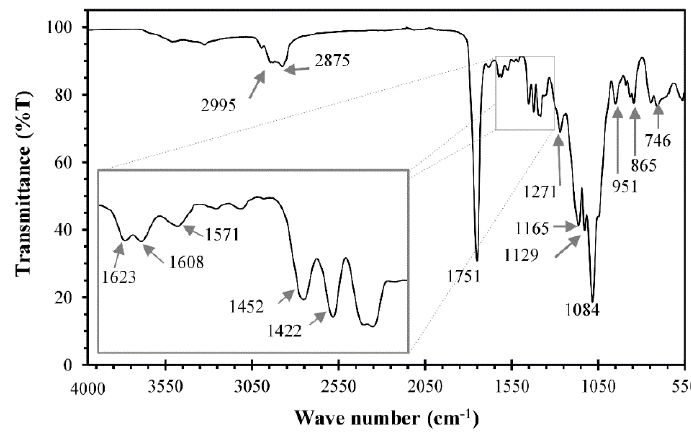
Figure 2. FT ‐ IR absorption peaks of PLGA ‐ PEG ‐ FA polymer. Characteristic bands for aromatic ring Figure 2. FT-IR absorption peaks of PLGA-PEG-FA polymer. Characteristic bands for aromatic ring present in folic acid at 1452 and 1608 cm − 1 and PLGA ‐ PEG ‐ FA representative absorption peaks at 1623 present in folic acid at 1452 and 1608 cm − 1 and PLGA-PEG-FA representative absorption peaks at 1623 and 1571 cm − 1 due to the presence of –CONH– linkage. and 1571 cm − 1 due to the presence of –CONH– linkage.